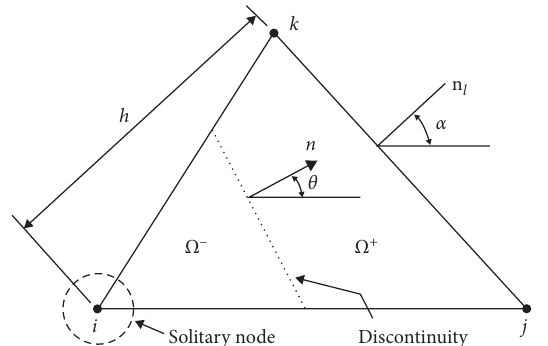
Figure 10: Geometry parameters for constructions of the matrix B c